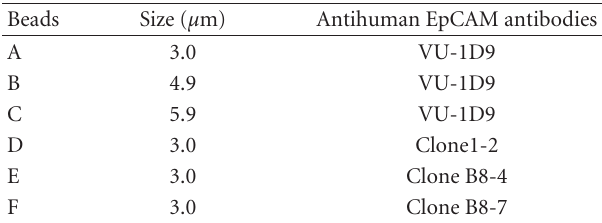
Table 1: New immunomagnetic beads.